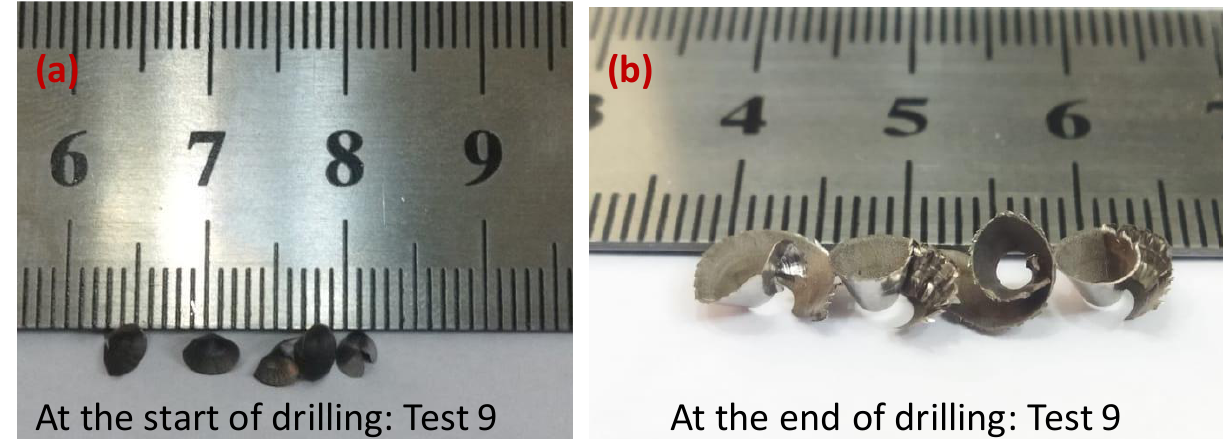
Figure 8. Chips produced during the experiment at ( a ) the start of drilling Test 9 and ( b ) the test cessation of Test 9.